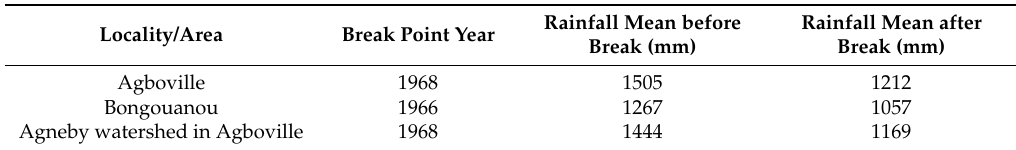
Figure 2. Rainfall index at ( A ) the Agboville rain gauge, ( B ) the Bongouanou station, and ( C ) the Agneby watershed at the Agboville outlet. Table 3. Years of break in the rainfall series. Locality/Area